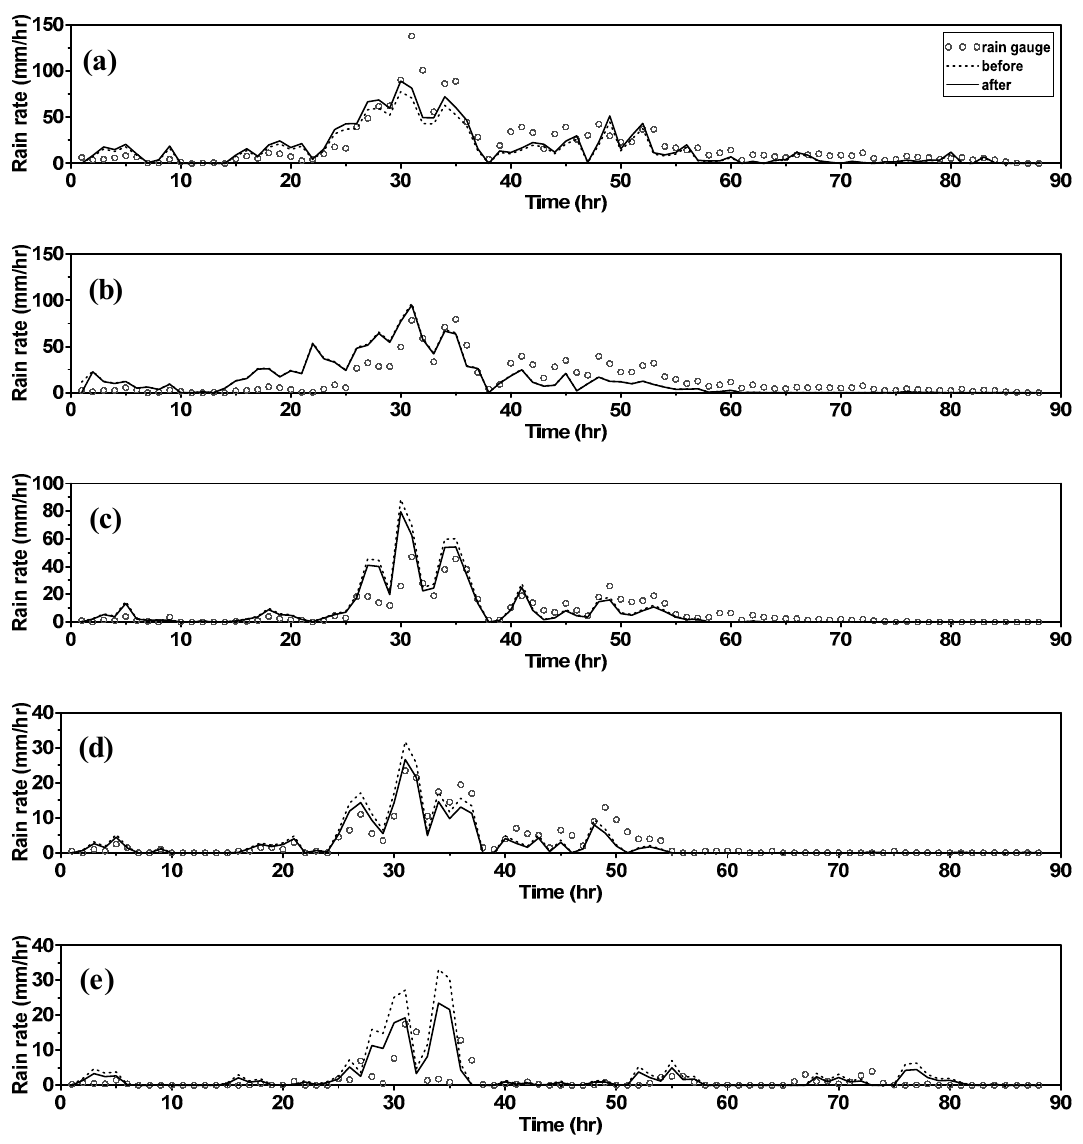
Figure 10. Comparison of radar and rain gauge rain rate before and after the G/R correction at several AWS locations ( a ) #871 (Witse-Oreum, 1750 m); ( b ) #870 (Jindallebat, 1500 m); ( c ) #782 (Seongpanak, 1000 m); ( d ) #751 (Seonheul, 500 m); and ( e ) #189 (Seoqwipo, 250 m).